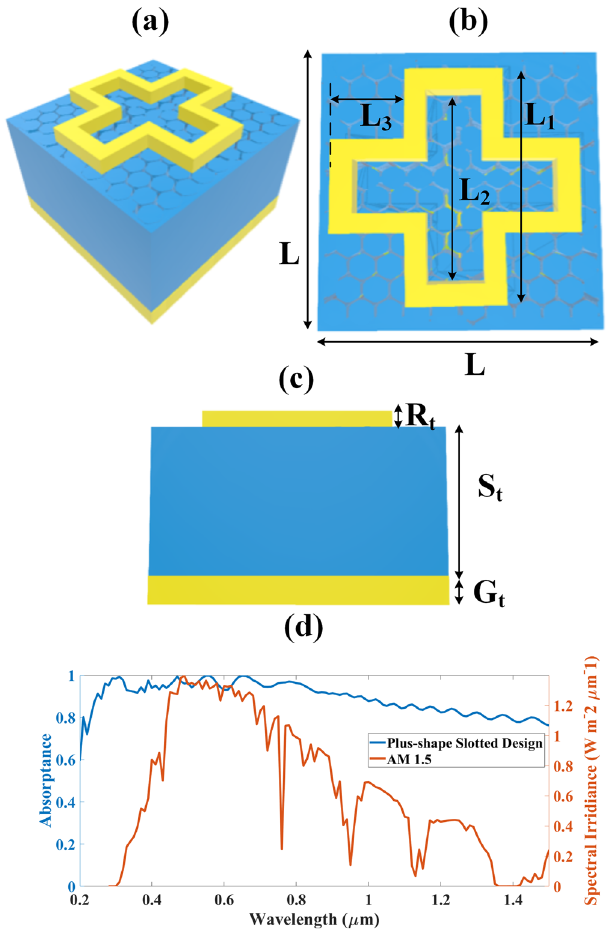
Figure 1. Plus-shape metamaterial-based solar absorber design ( a ) 3D view, ( b ) Top view, ( c ) Front view, ( d ) Ultra-broadband absorption response of plus-shape slotted metamaterial-based solar absorber design with AM 1.5. The parameters are: L = 3 µm, L 1 = 1.9 µm, L 2 = 1.4 µm, L 3 = 1 µm, S t = 8 µm, G t = 0.5 µm, R t = 0.5 µm. The figure is not up to the